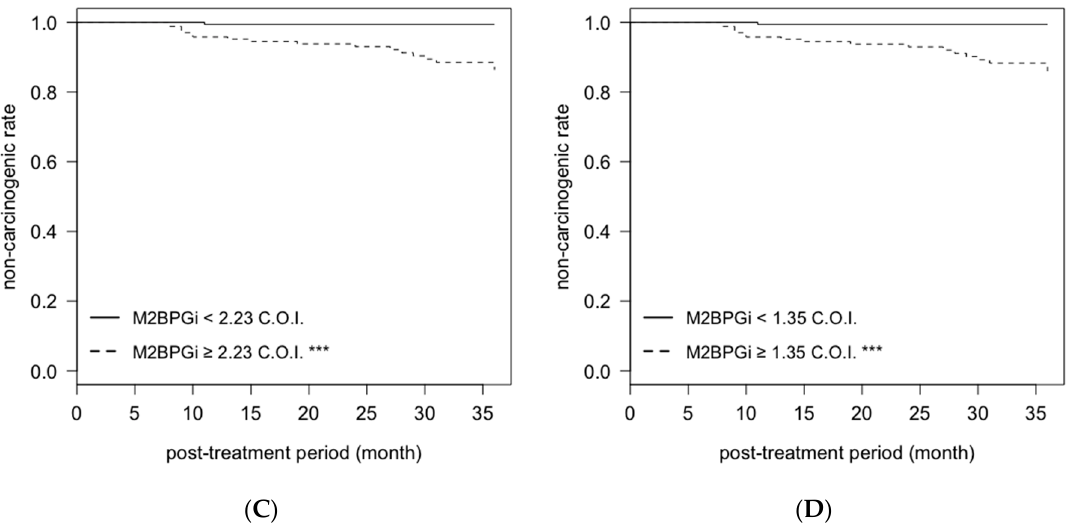
Figure 5. Cumulative non-carcinogenic rate after antiviral treatment. Data from Cohort A were used for the analysis. ( A , B ) indicate data by serum levels at 12 / 24 weeks after antiviral treatment in male patients. Data from female patients before treatment are shown in ( C ), and from female patients at 12 / 24 weeks after antiviral treatment are shown in ( D ). ***: p < 0.001. ATX: autotaxin; M2BPGi: Wisteria floribunda agglutinin positive Mac-2 binding protein.